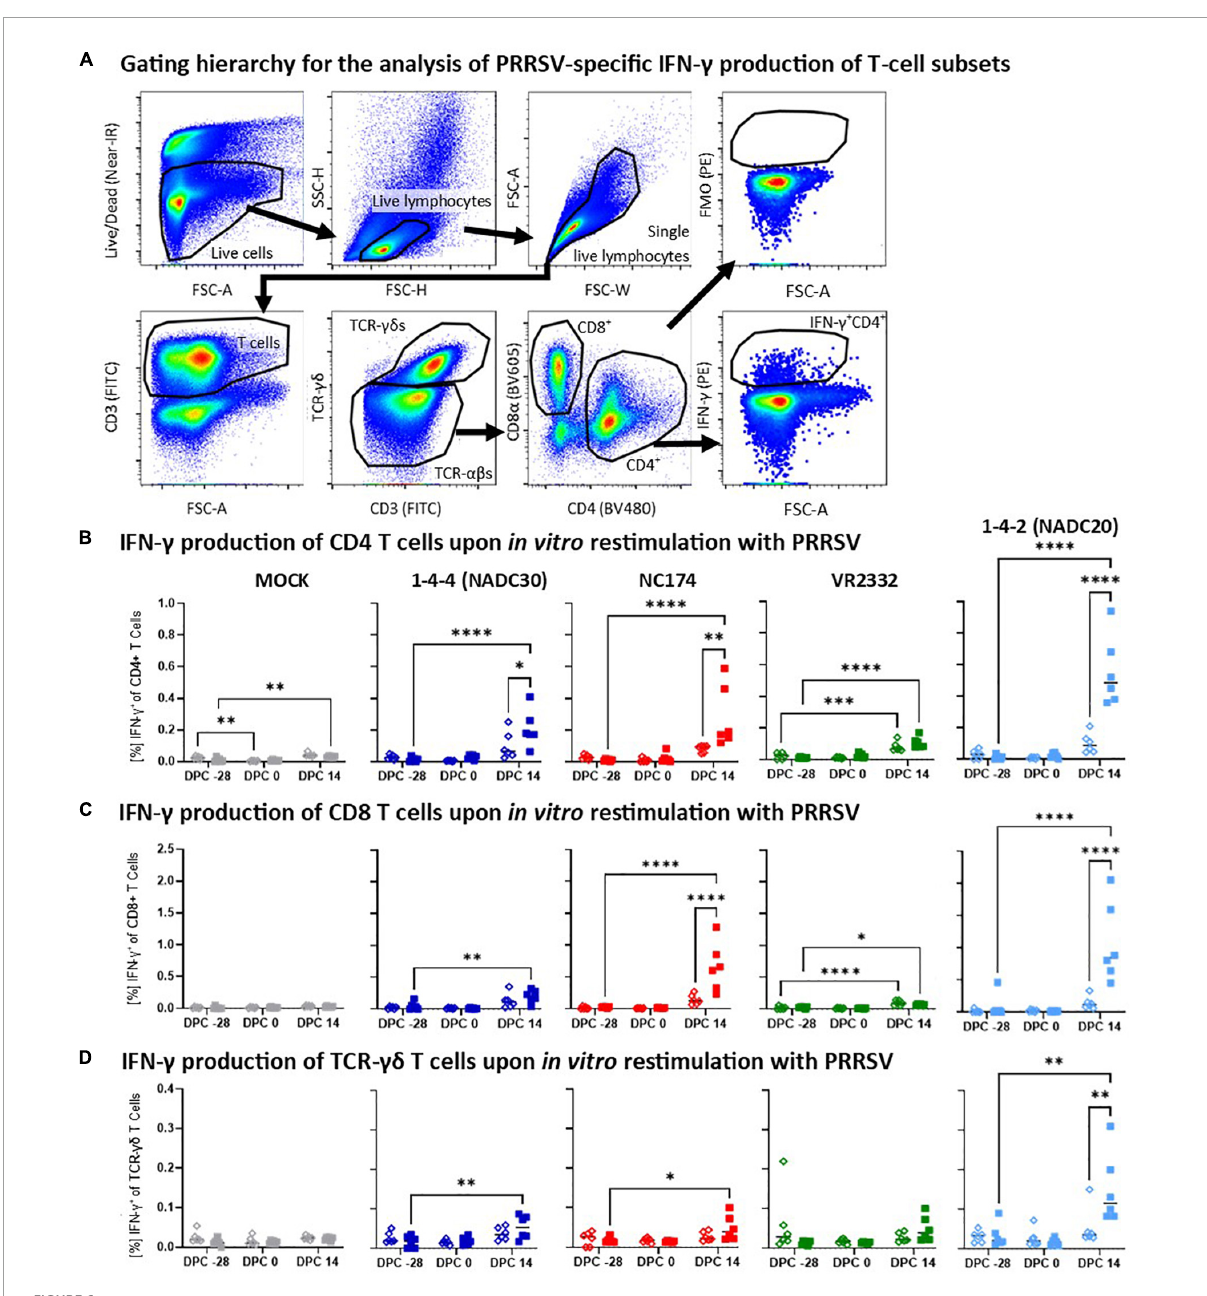
FIGURE6 Heterologous vaccine immunogenicity—IFN- γ production of CD4, CD8, and TCR- γδ T cells. (A) Gating hierarchy to assess the heterologous IFN- γ response of T-cell subsets to the respective PRRSV type-2 challenge strains. The gating hierarchy follows largely the proliferation analysis shown in Figure 5 . However, instead of gating on proliferating cells, IFN- γ was analyzed in a FSC-A/IFN- γ plot. The IFN- γ gate was set using the appropriate FMO control (top right plot). Panels (B–D) show the IFN- γ responses of CD4 (B) , CD8 (C) , and TCR- γδ T cells (D) according to their challenge groups—MOCK (gray), 1-4-4 (NADC30, dark blue), NC174 (red), VR2332 (green), and 1-4-2 (NADC20, light blue). The black bars represent the median values; in addition, individual data points are shown for MOCK vaccinated animals (open diamonds) and MLV vaccinated animals (filled squares). Data were statistically analyzed using a 2-way ANOVA with time and vaccination as the two parameters and Tukey’s multiple comparison test. ∗∗∗∗ p < 0.0001, ∗∗∗ p < 0.001, ∗∗ p < 0.01, ∗ p < 0.05.